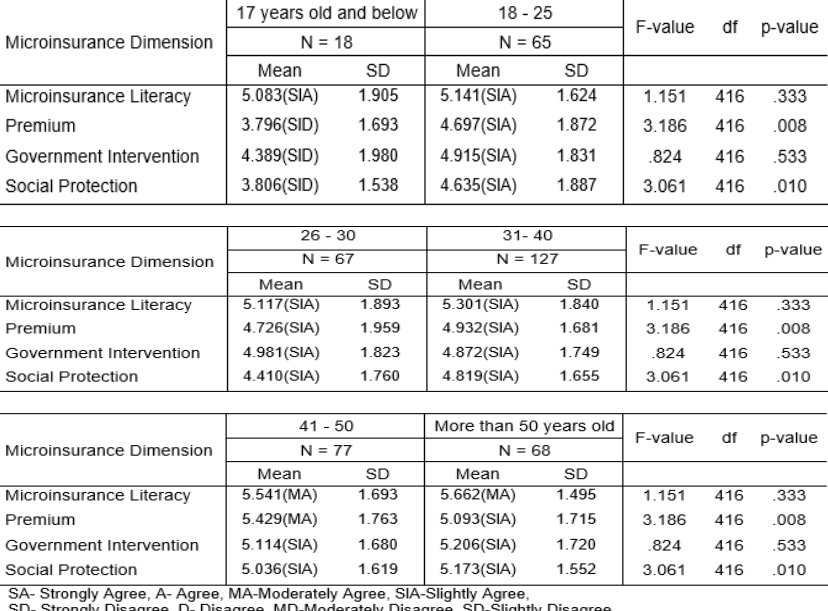
Table 8: Level of Agreement of the Respondents on the Dimensions of Microinsurance When Grouped According to